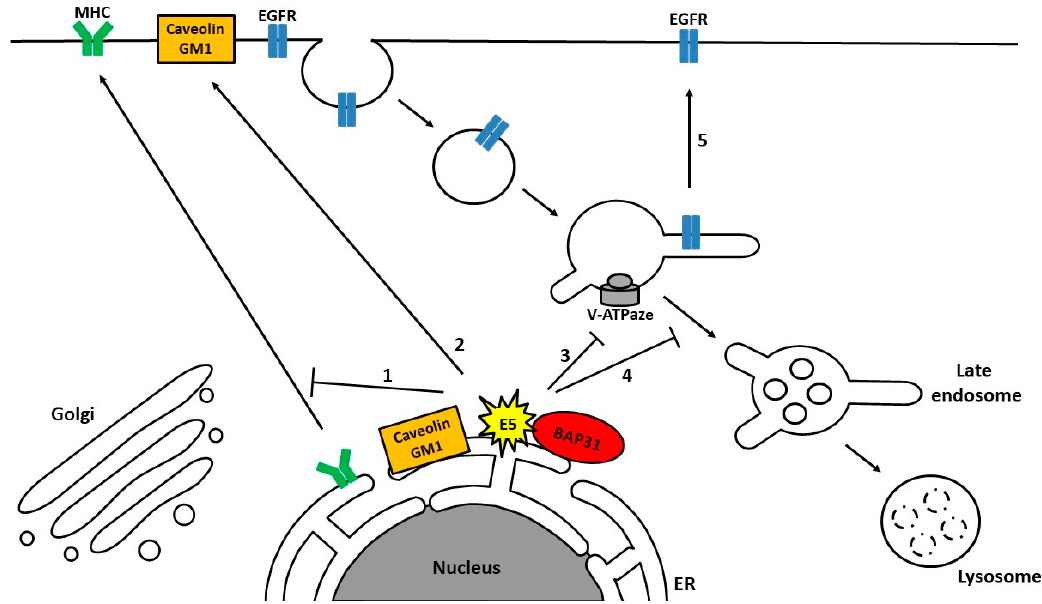
Figure 2. Model representing possible molecular mechanisms by which E5 manipulates trafficking pathways and potentially predisposes the infected cell towards cancer development. E5 inhibits the transport of immune receptors (MHCI, MHCII, CD1d) to the cell surface, and prevents clearance of infected cells by the immune response (1). It also upregulates the cell surface expression of caveolin-1 and ganglioside GM1 (2). Moreover, E5 can inhibit endosome acidification (3) or the trafficking from early to late endosomes (4) which may promote recycling of EGFR to the cell surface and lead to aberrant proliferation (5). Note that E5 localizes primarily to the endoplasmatic reticulum (ER), but it can also be found in the Golgi apparatus, in perinuclear regions and on the plasma membrane. E5 can also modulate other receptors such as keratinocyte growth factor receptors/fibroblast growth factor receptors 2b (KGFR/FGFR2b), which are required for the regulation of cell